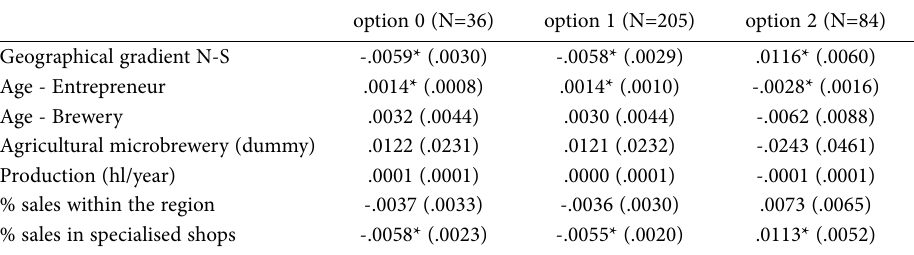
Table 8. Ordered Logit estimation: conditional marginal effects for the 3 options (estimated standard errors in